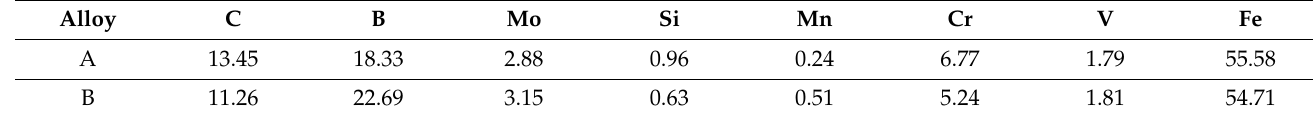
Figure 3. EDS analysis of as-cast alloy B. Table 2. EPMA test results of B-rich carbides (at.%).